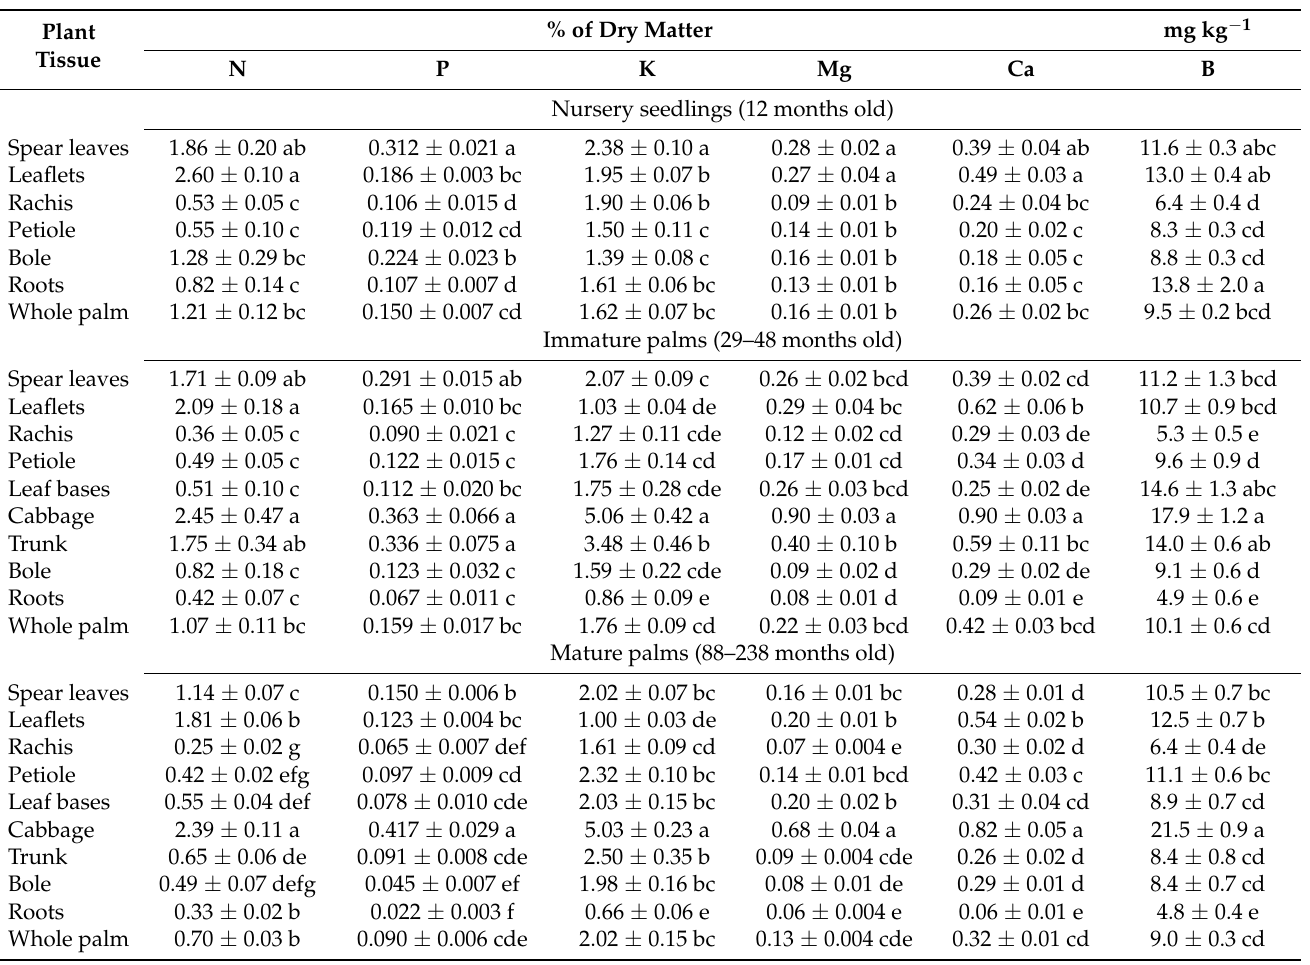
Table 5. Concentrations (mean ± SE) of N, P, K, Mg, Ca, and B in vegetative tissues of nursery, immature, and mature tenera oil palms.